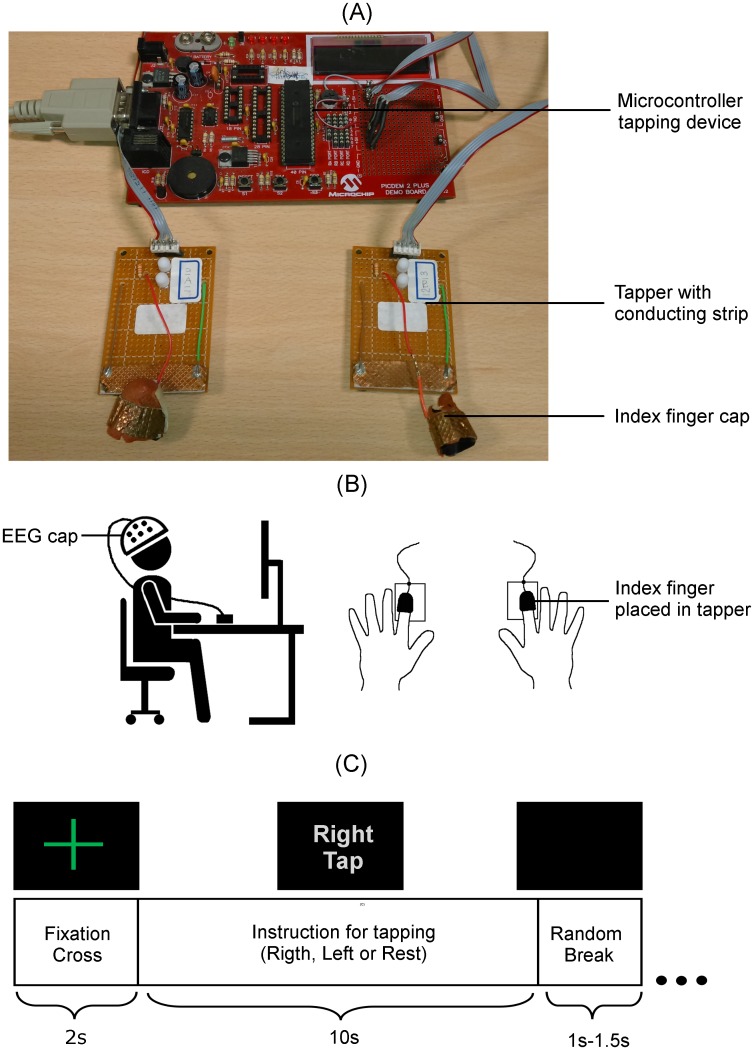
Experimental setup, devices and EEG trial structure.(A) Microcontroller tapping device to record right and left index finger taps, which were co-registered with the EEG to mark the tap onset. (B) Illustration of the EEG experimental setup and index fingers placed in the tapping device. (C) Structure of single EEG trial.